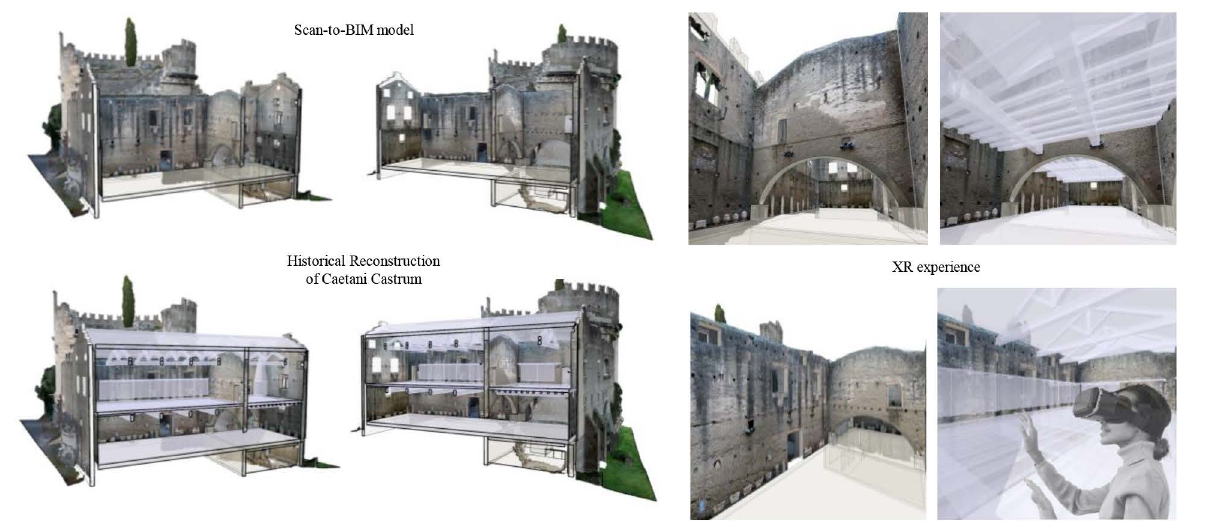
Figure 10. The Scan-to-BIM model, the historical reconstruction and XR experience of Caecilia Metella and Caetani Castrum.